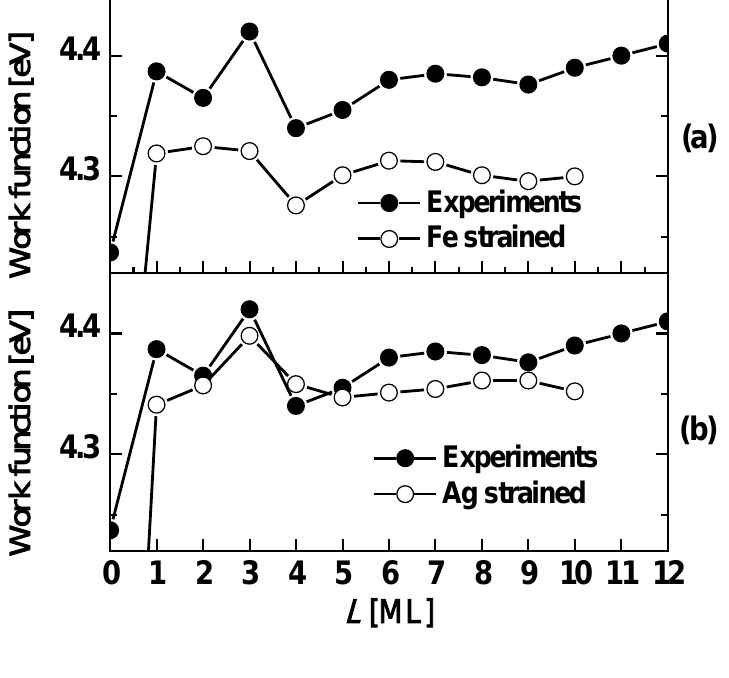
Figure 7. The work function versus Ag(100) film thickness on Fe(100). The curves with open circles correspond to DFT calculations: (a) with the theoretical in-plane lattice constant of the Fe substrate is slightly strained to conform to that of Ag; (b) with the theoretical in-plane lattice constant of Ag on a Fe substrate strained to conform to an unstrained Fe substrate (presumably representing the experimental situation for defect free films). In both cases, the (identical) curve with filled circles is the experimentally measured work function. Adapted from [58] (Copyright American Physical Society